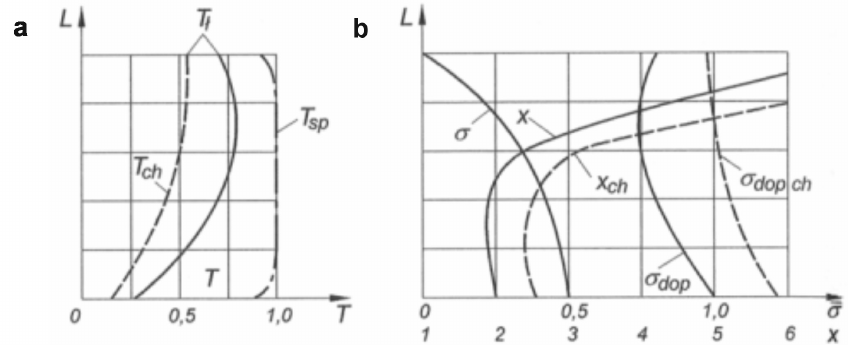
Fig. 7. The distribution of selected parameters along the L turbine blade leaf of the turbine rotor: a) T exhaust gas temperature, T uncooled blade temperature and T stress in the turbine blade leaf without a plate σ and with a plate σ corresponding x and